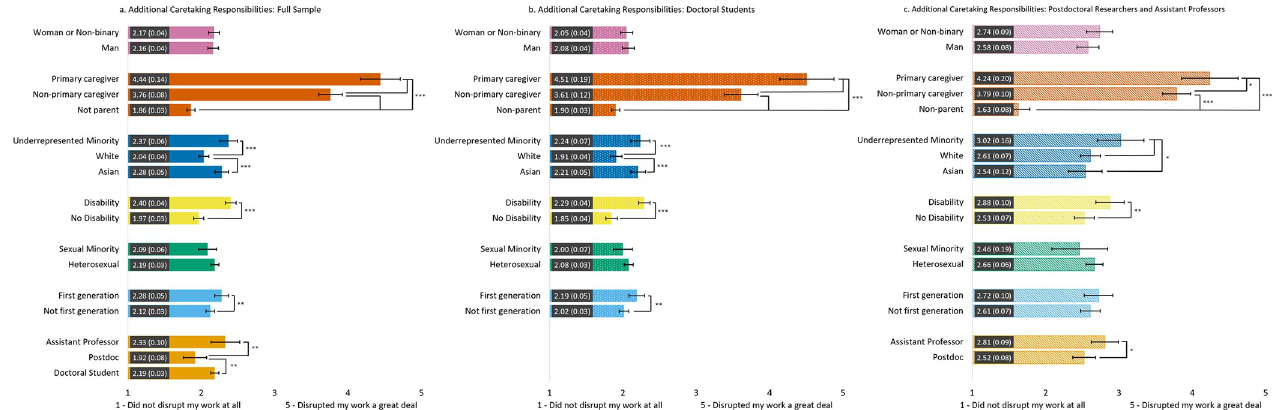
Fig 7. Estimated marginal means of disruptions to work due to additional caretaking responsibilities during the COVID-19 pandemic for the full sample (7a) and doctoral student (7b) and postdoc/asst prof (7c) subsamples. Participants were asked to rate the degree to which additional caretaking responsibilities due to the COVID-19 pandemic disrupted their work with a Likert scale from 1 = Did not disrupt my work to 5 = Greatly disrupted my work . Error bars represent the 95% CI. Numeric values in each bar are the estimated marginal mean and standard error. � indicates p < .05, �� indicates p < .01, and ��� indicates p < .001. See supplemental Table S9 for results of each